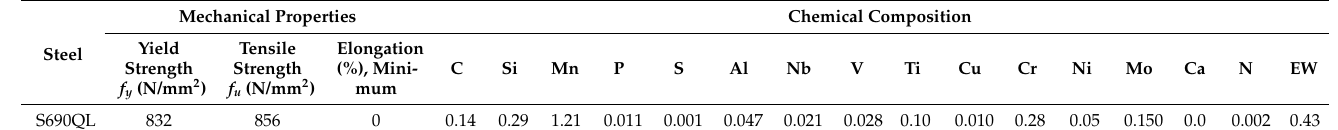
Table 1. Mechanical properties and chemical compositions of S690QL.